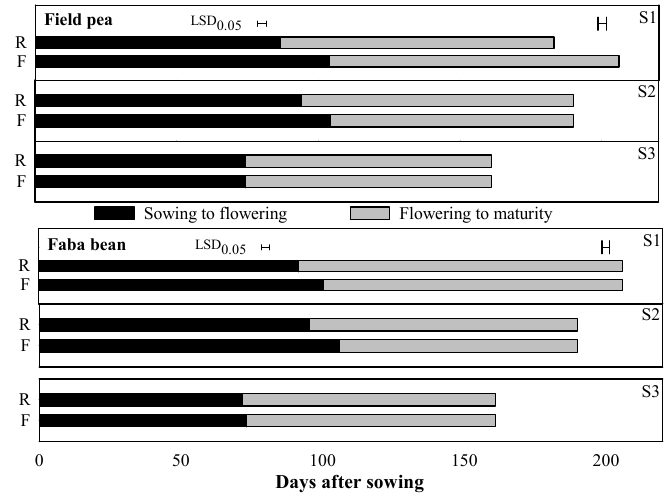
Figure 5. Duration from sowing to flowering (black) and flowering to maturity (grey) in field pea ( A ) and faba bean ( B ) crops grown in post-rice (R) and post-fallow (F) soils, at three different sowing dates (S1, S2 and S3). The horizontal error bars (smaller capped bar for flowering time and larger capped bar for maturity time) represent LSD values at the 0.05% level of significance.